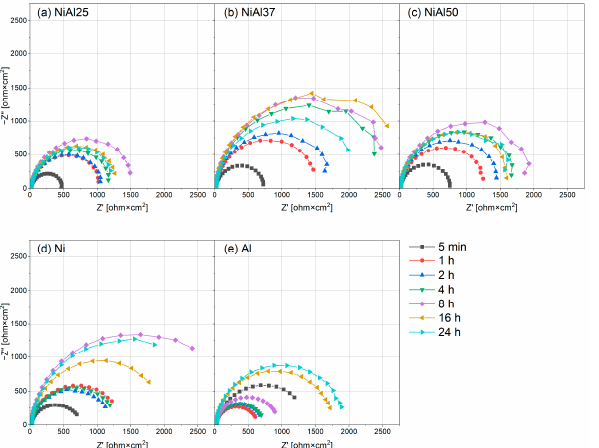
Figure 9. Nyquist representation of impedance data obtained in 0.1 M H 2 SO 4 , ( a ) NiAl25, ( b ) NiAl37, ( c ) NiAl50, ( d ) Ni and ( e ) Al.